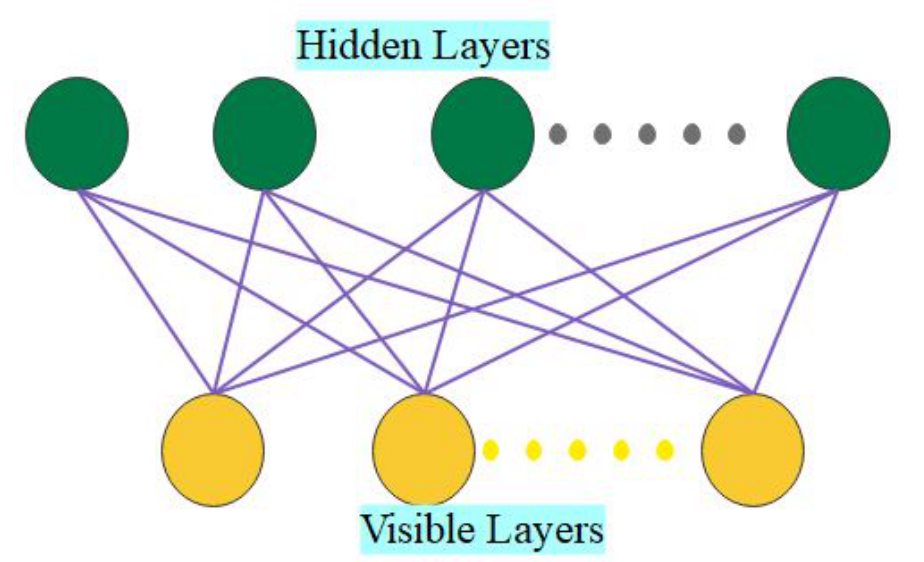
Figure 8. The Structure of Restricted Boltzmann Machine Model.